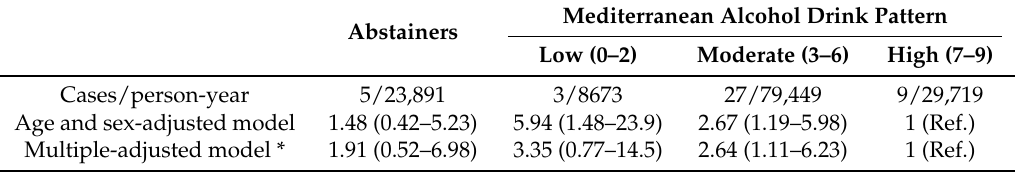
Table 3. Hazard ratios and 95% confidence intervals of cardiovascular mortality according to the categories of adherence to the Mediterranean alcohol-drinking pattern. The Seguimiento Universidad de Navarra (University of Navarra follow-up) (SUN) project